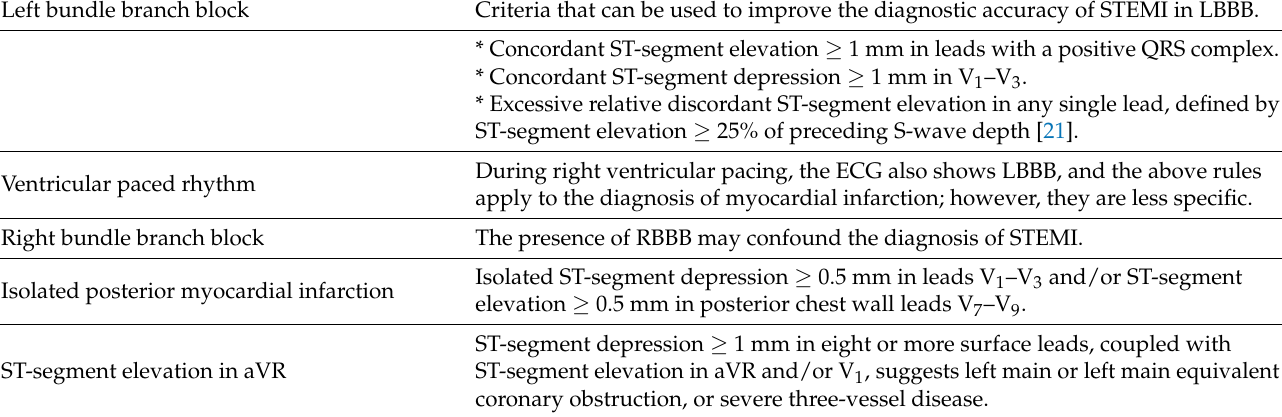
Table 1. Definition and classification of STEMI-equivalent electrocardiogram according to the 2017 STEMI guidelines from the European Society of Cardiology